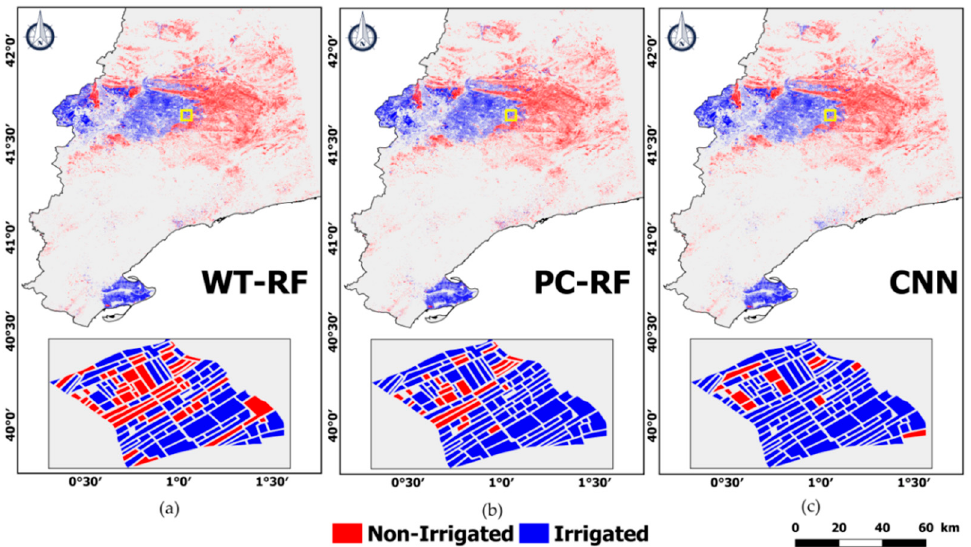
Figure 10. Irrigation mapping using the ( a ) WT-RF model, ( b ) PC-RF model and ( c ) the CNN model. Irrigated areas are presented in blue while non-irrigated areas are shown in red. A zoom version of the yellow box in each map is provided to better visualize different classification results.